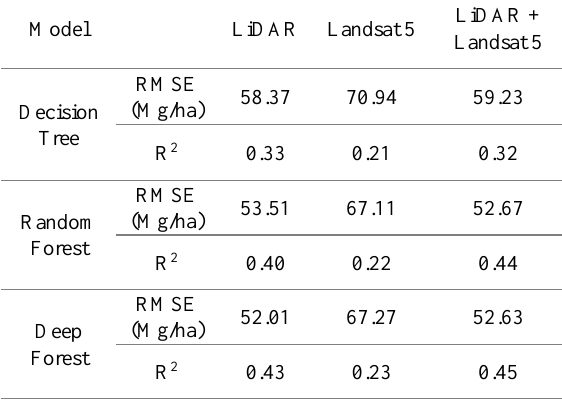
Table 3 . Results of HWF AGB estimation using decision tree, random forest, and deep forest models and integration of LiDAR and Landsat 5 TM